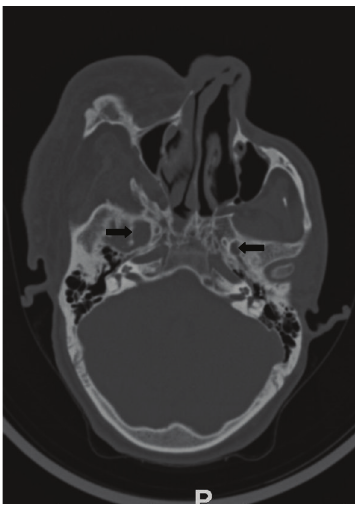
Figure 12: Axial CT scan showing lipomatous enlargement of the soft tissue on right side of face including buccal region, lips, tongue, soft palate, and right parotid gland (asterix).